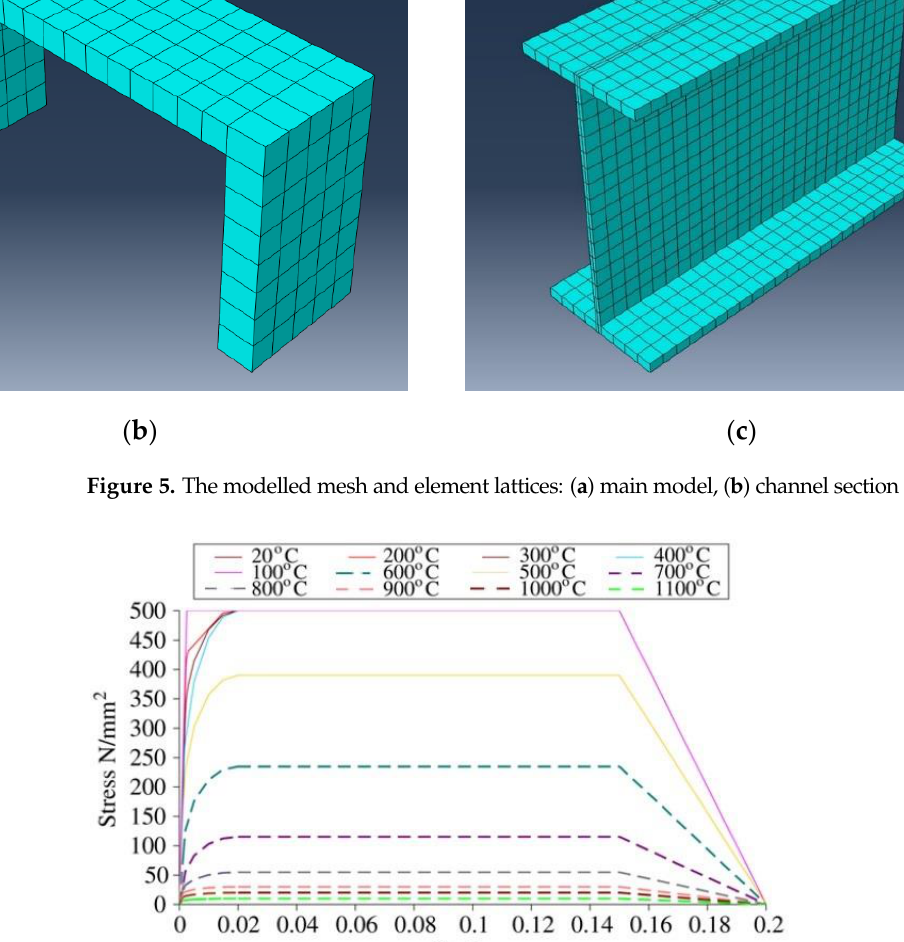
Figure 6. Stress-strain relationship at elevated temperature for structural steel, EC3 British Stand- ards Institution.